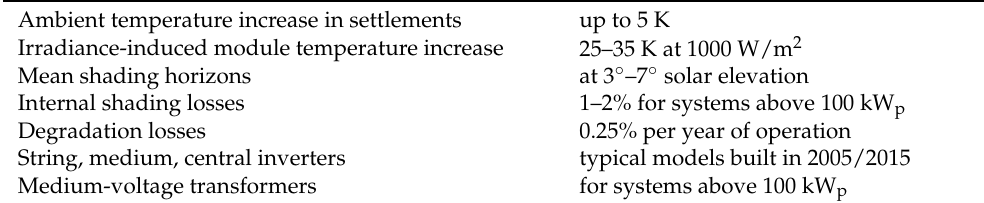
Table 1. Technical and environmental parameters used for the PV power simulation with the range of values for the different classes of PV